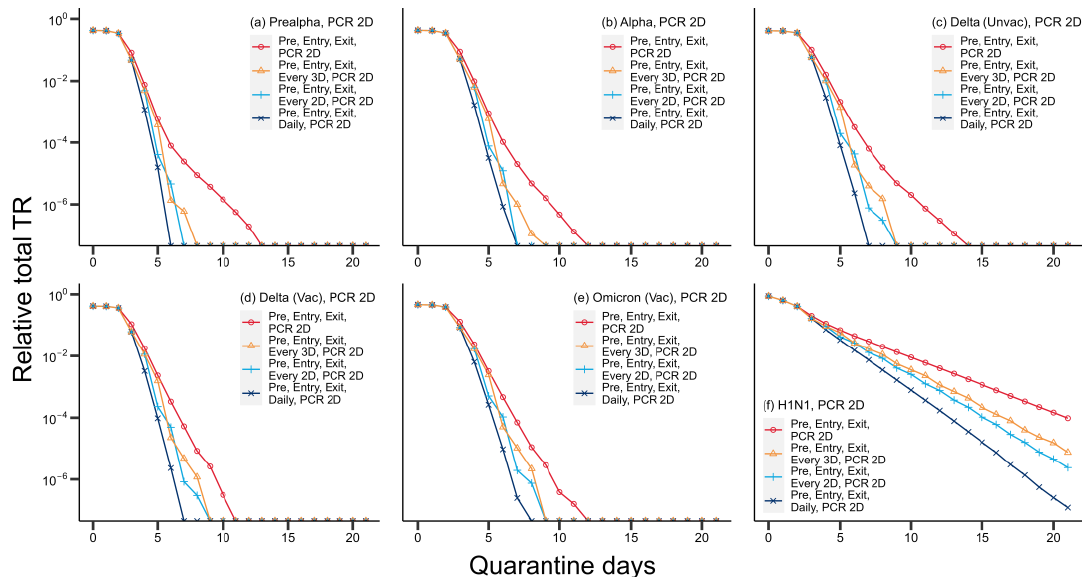
Figure 6. Mean relative total TR for strategies based on PCR 2D by virus variant: ( a ) prealpha, ( b ) alpha, ( c ) delta unvaccinated, ( d ) delta vaccinated, ( e ) omicron vaccinated and ( f ) influenza A- H1N1. Strategies include: pretesting, entry testing and exit testing (red with circles); pretesting, en- try testing, testing every three days in quarantine and exit testing (orange with triangles); pretesting, entry testing, testing every two days in quarantine and exit testing (light blue with ticks); and pre- testing, entry testing, testing every day in quarantine and exit testing (dark blue with crosses).